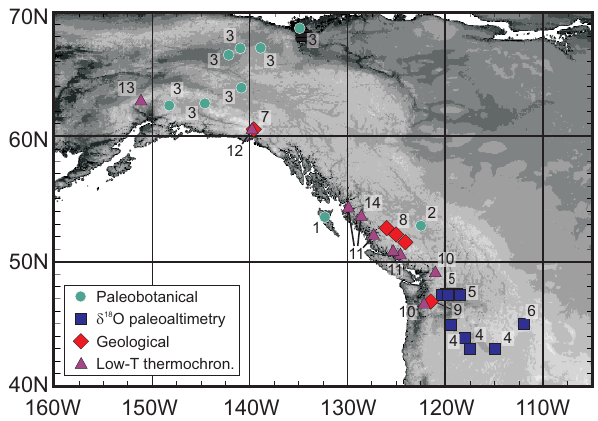
Fig. 2. Digital elevation model of the North American Continent showing the location of much of the published data used in the text divided according to the data type. 1 – Martin and Rouse